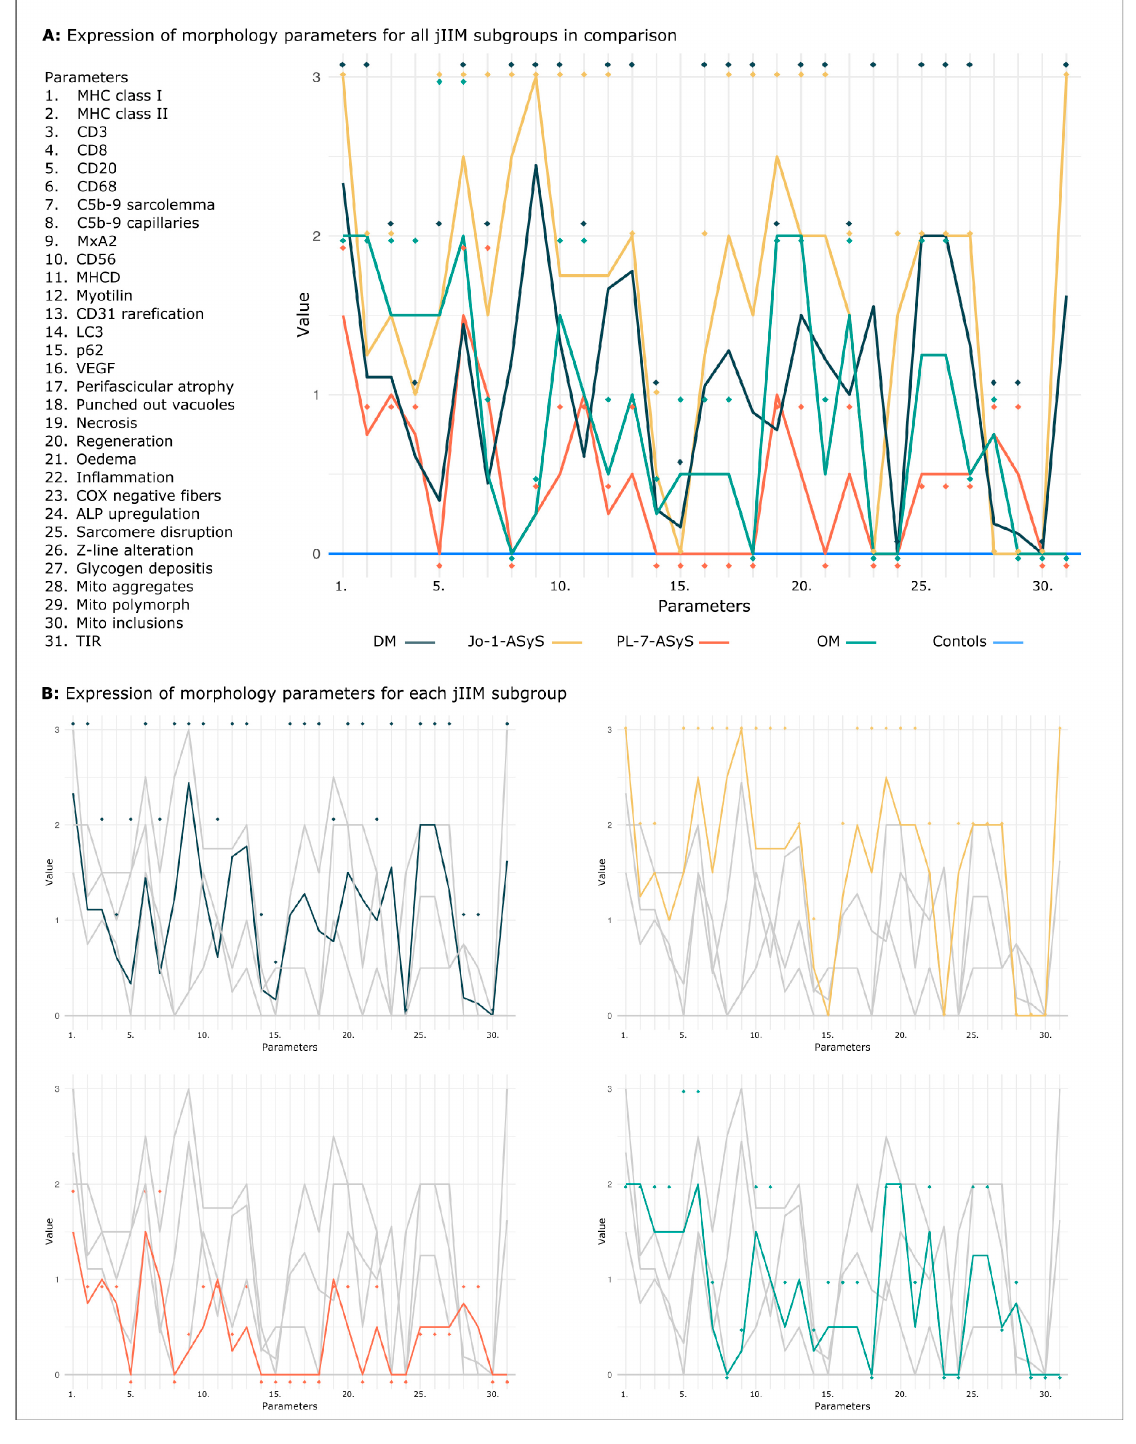
Figure 9. Visual exploration of the values. Common and discriminative morphological patterns in jIIM subgroups DM, ASyS, OM, and controls for 31 parameters, shown as mean (coloured lines) and maximum values (rhombus) per subgroup as an overview ( A ) and separated by subgroups ( B ). The minimum values per subgroup representing weak morphological characteristics are not shown. Healthy control (blue line) shows the normal pattern. Note the visible similar trend of the pattern of DM and Jo-1- ASyS compared to that in PL-7- ASyS and OM. For all parameters, the p -value did not reach statistical significance. (DM = dermatomyositis; ASyS = antisynthetase syndrome; OM = overlap myositis, TIR = tubuloreticular inclusions).